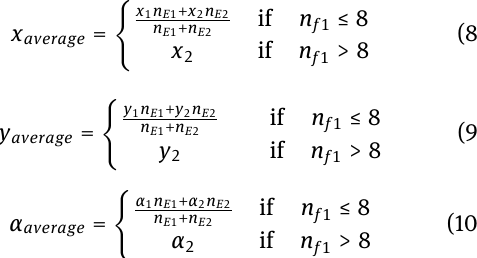
the corresponding foot. The program analyzes the data from the laser range scanner and calculates the position and direction of the trainee’s